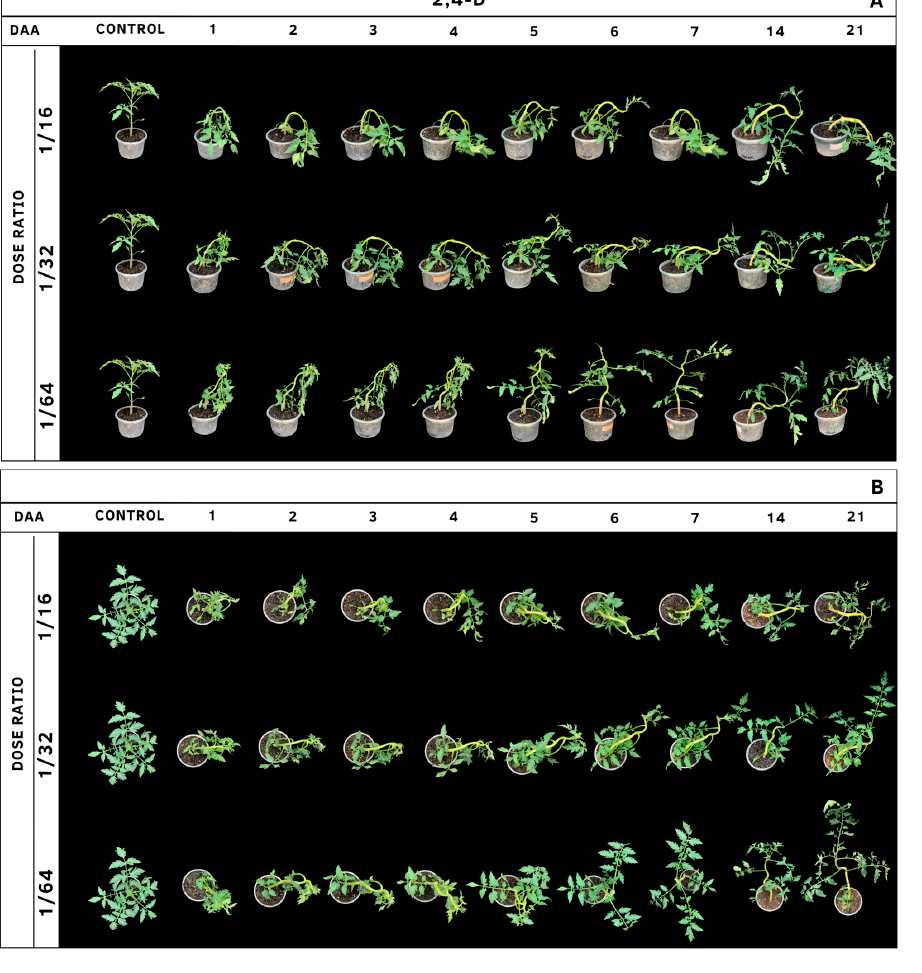
Figure 2. The e ff ects of simulated 2,4-D drift with a close-up view show injuries in tomato plants.